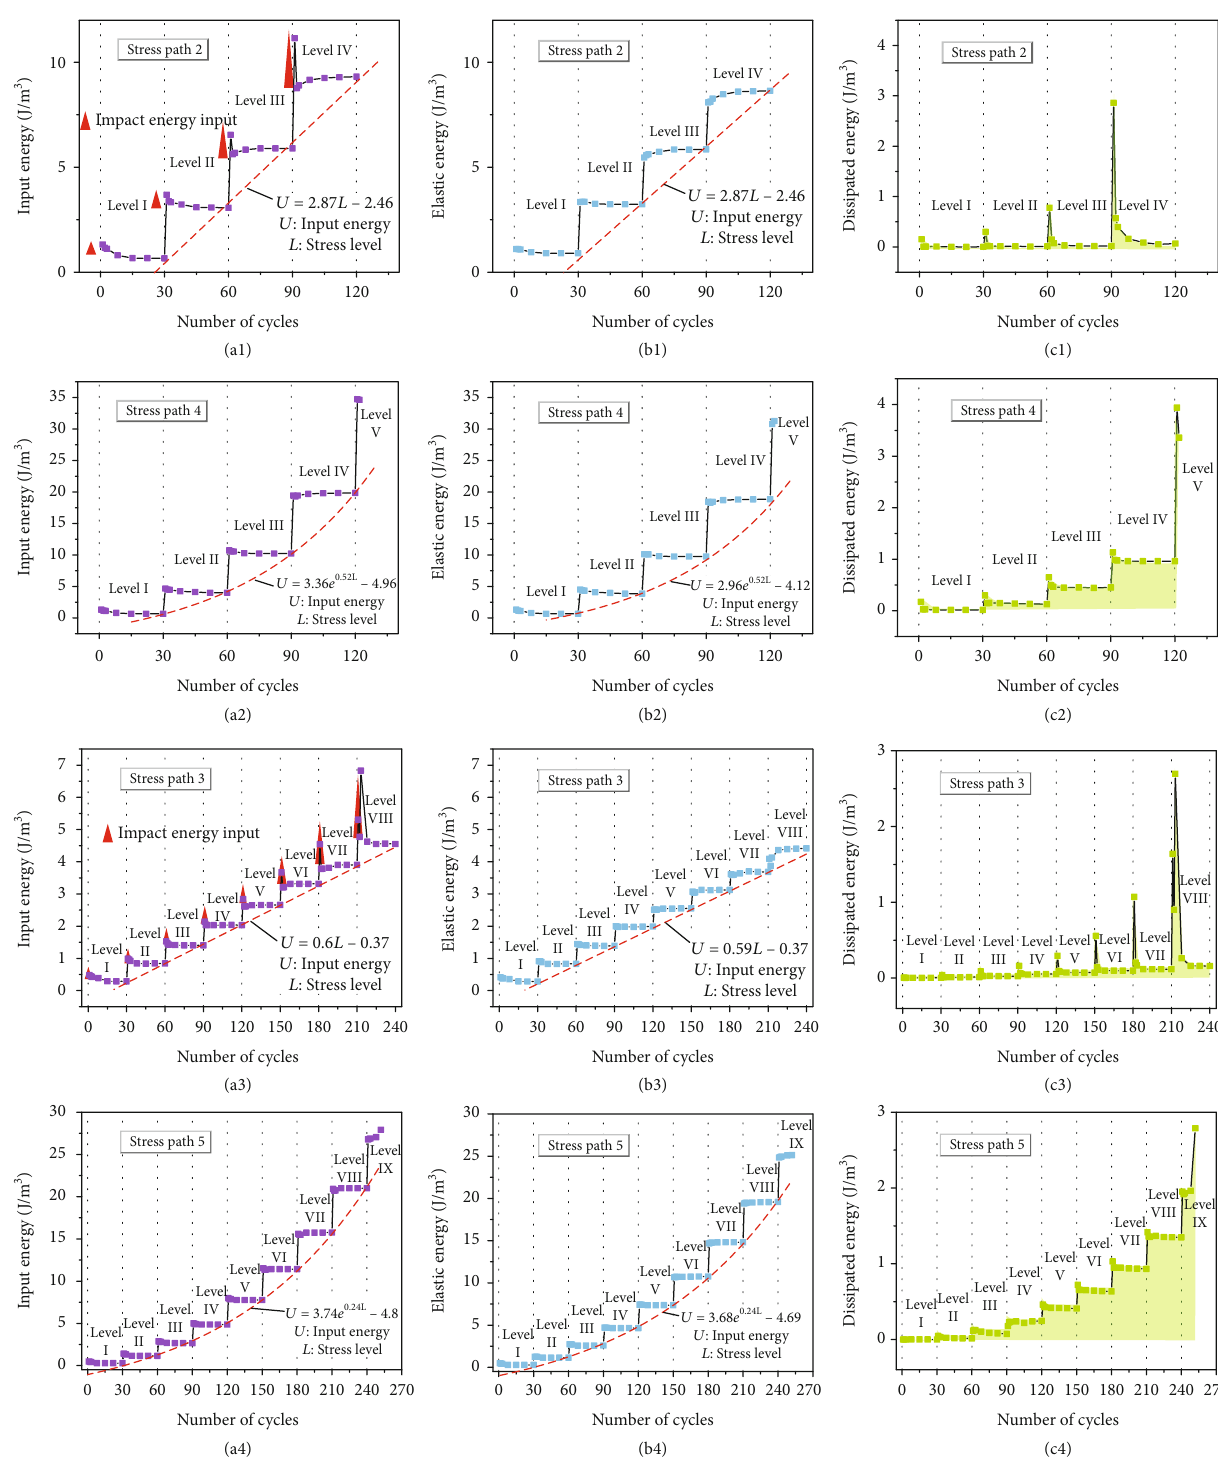
Figure 12: Energy evolution diagram in step cyclic loading stress paths. (a1) – (a4) The evolution of U with the accumulation of cycle times under stress paths 2-5; (b1) – (b4) the evolution of U e with the accumulation of cycle times under stress paths 2-5; (c1) – (c4) the evolution of U d with the accumulation of cycle times under stress paths